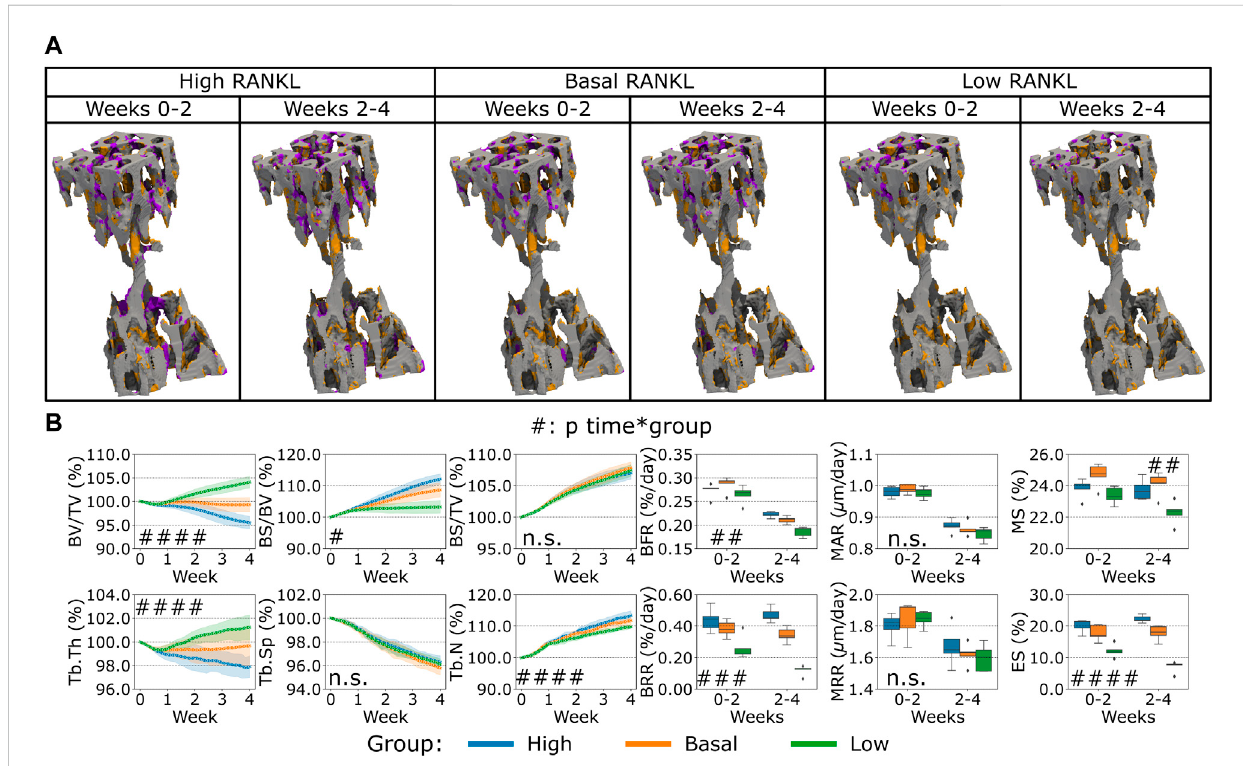
FIGURE 5 In silico results of variations of the maximum single cell production level of receptor activator of nuclear factor kB ligand (RANKL) by osteocytes. (A) Biweekly FQR regions of results obtained with higher and lower RANKL productions levels for the representative mouse (number 5). Bone formation in orange, quiescence in gray, and resorption in purple. (B) Static and dynamic bone morphometry parameters of the results of the simulations of the same group of mice (n = 5) under three different production levels of RANKL, starting from the same initial condition of the basal level. High =